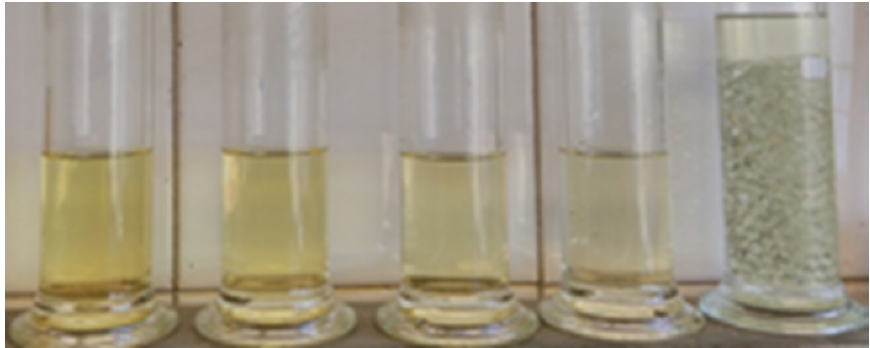
Figure 5. Tar and wax captured in isopropanol after installing a secondary catalytic reactor. A comparison of tar yields of a two stage catalytic system with a system without a catalyst (data from Table 2) shown in Figure 6a proved that Ni-impregnated clay reduced the tar and wax yield by up to 91.8%. The effect of the Ni-based catalyst on the removal of tar from waste and biomass gasification was confirmed also by other authors [32,33]. Furthermore, the influence of the temperature in the catalytic process is significant, as can be seen in Figure 6b (Y axis zoom in); an increase in the temperature from 700 ◦ C to 900 ◦ C decreased the tar yield by around 45%. Compared to the simple one-stage semi-batch gasification, no wax fraction in the form of a solid phase in isopropanol was observed in the two-stage catalytic system. High molecular weight polymer segments in the gasifier prod- uct can have an extremely negative effect on the downstream processing of the generated gas; therefore, simple one-stage semi-batch gasification of RDF is not